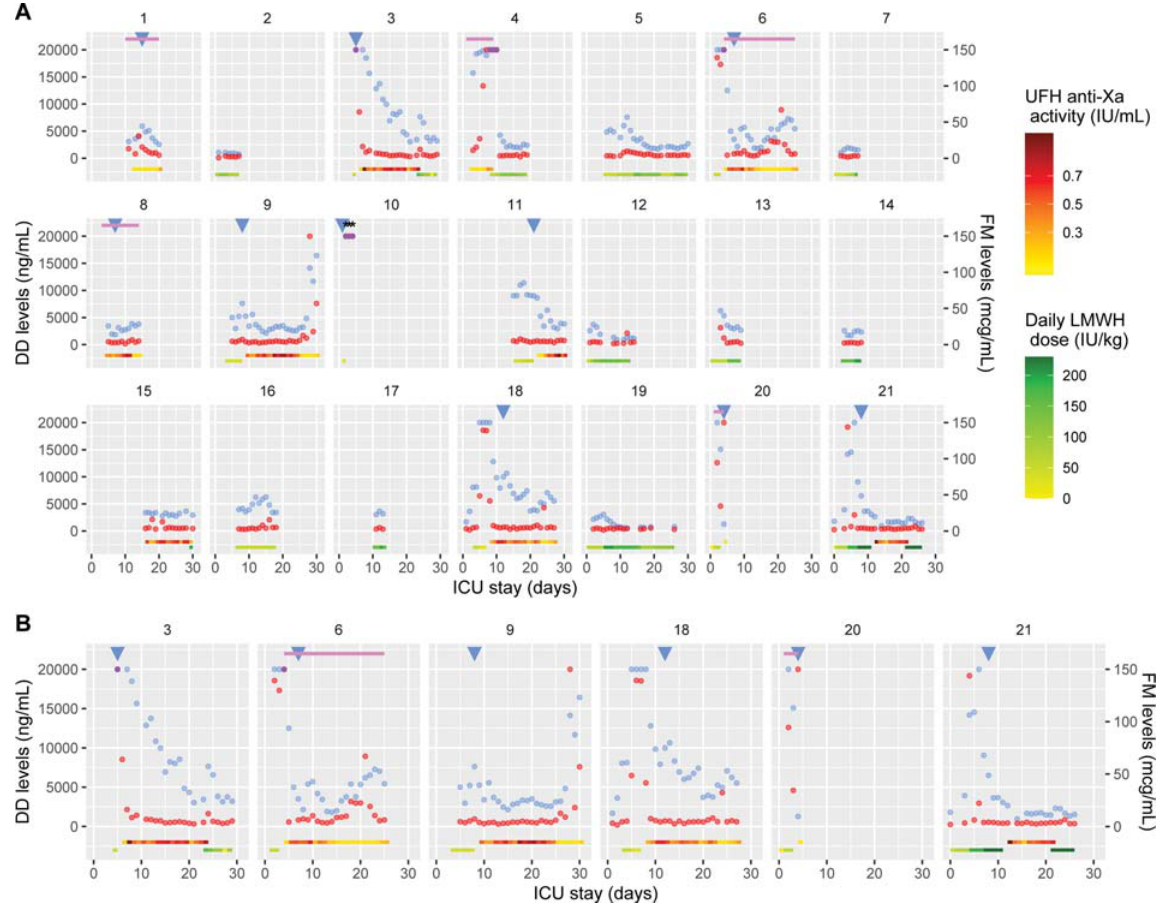
Fig. 1 Daily changes of D-dimers and fi brin monomers (FM) plasma levels during the intensive care unit stay for the 21 study patients (A) and for the six patients with a FM peak (B). The late FRM peak in patient 9 followed radioembolization ofgluteal bleeding, which may explain the increase in FRM. 19 D0 is the day of fi rst ICU admission (11 patients were transferred from another ICU to ours). D-dimers levels are represented with blue dotsand FMlevels with red dots (purple dots correspond to superimposedvalues). Bluetriangles correspondto days of thrombosis diagnosis and black stars to days when ISTH criteria for overt disseminated intravascular coagulopathy were met (either using D-dimers or FM as fi brin-related markers 15 ). Upper pink lines represent the period of extracorporeal membrane oxygenation treatment. Daily LMWH (enoxaparin) received dose (green line) and achieved anti-Xa levels for UFH administration (red line) are represented in the bottom of the fi gure. UFH, unfractionated heparin; LMWH, low molecular weight heparin; DD, D-dimers; FM, fi brin